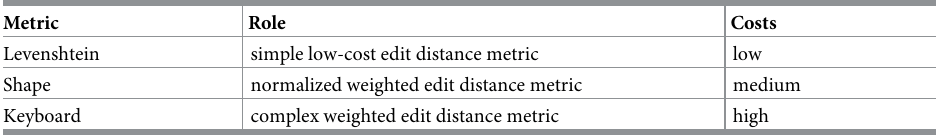
Table 1. Features of evaluated edit distance